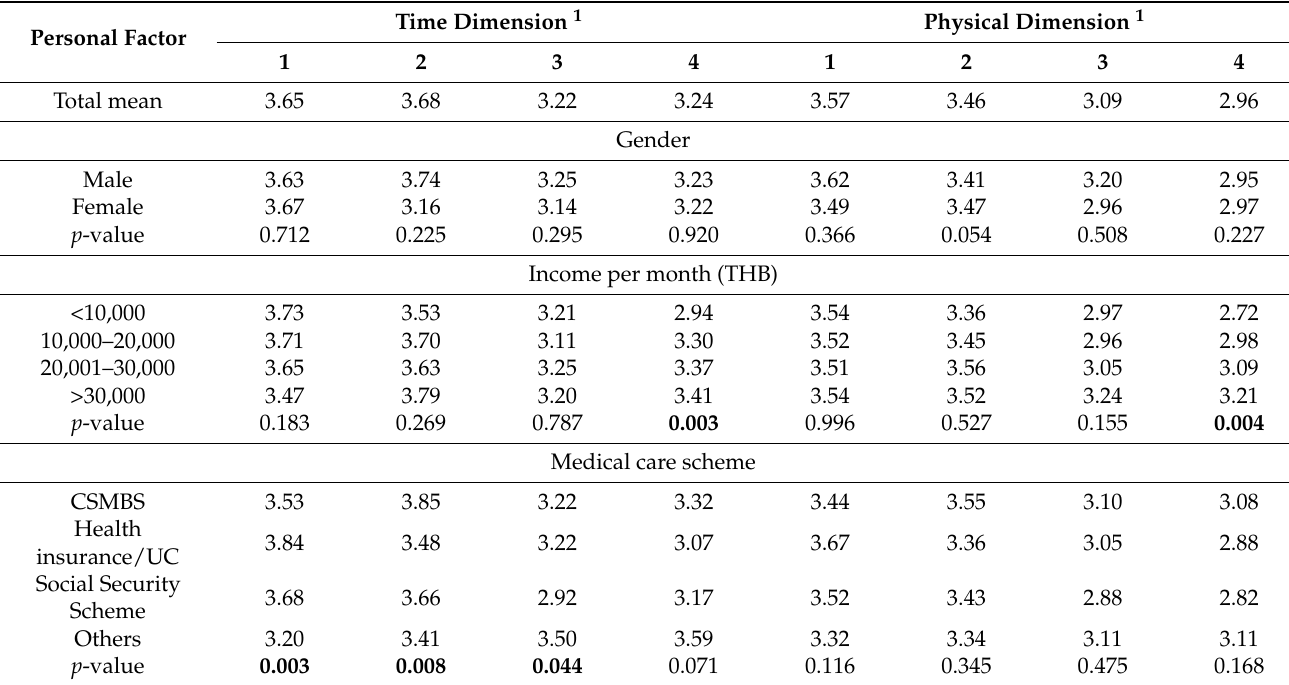
Table 4. The personal factors related to the five attitude scores for medicine delivery methods used by NCD patients ( n =